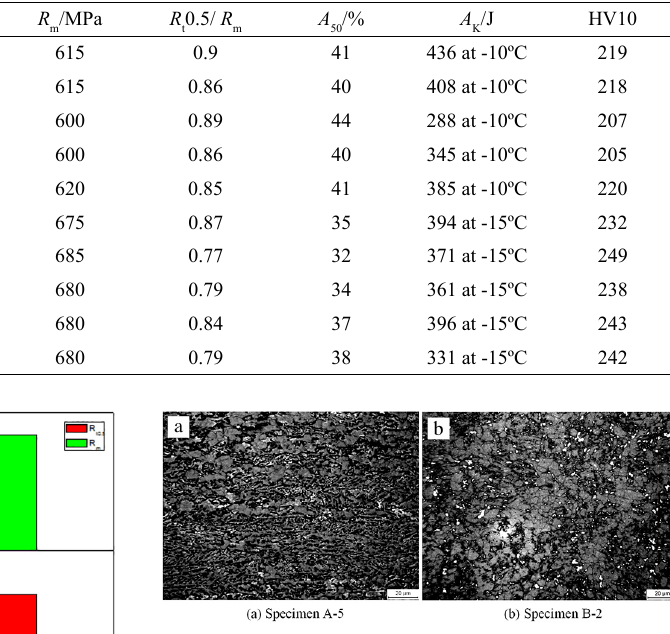
Figure 4. Optical micrographs of specimens after UFC process.